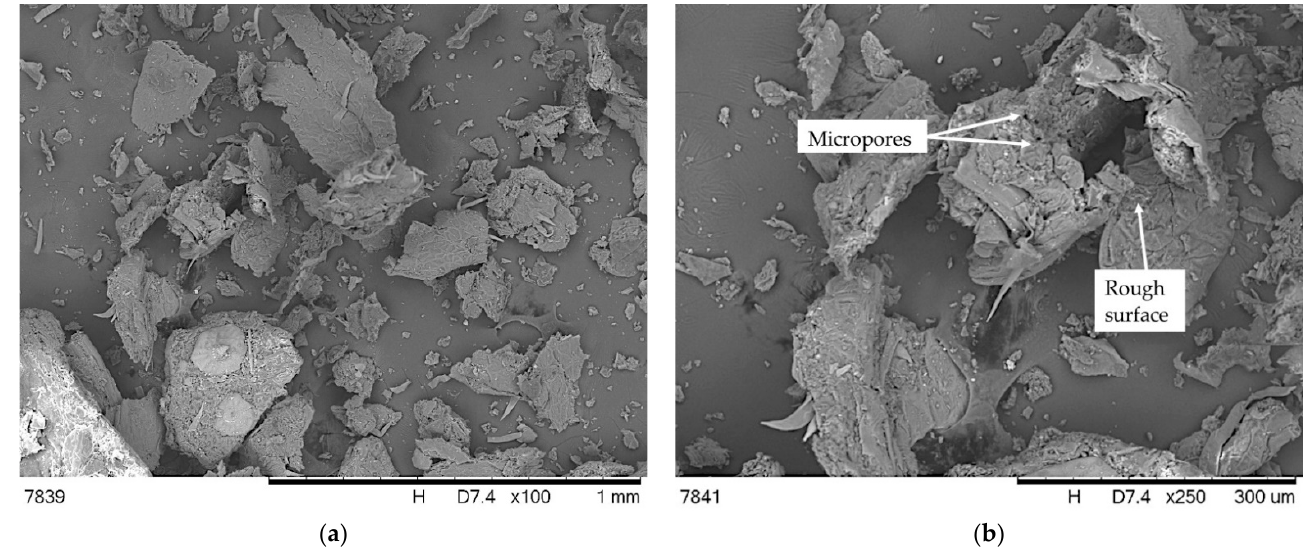
Figure 3. SEM images with different magnification of hop residue ( a , b ).